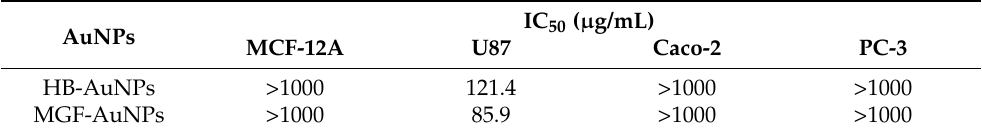
Figure 6. Investigation of the cytotoxic effects of HB-AuNPs and MGF-AuNPs in human cell lines. The in vitro effects of HB-AuNPs and MGF-AuNPs were tested in MCF-12A ( a ) U87 ( b ), Caco-2 ( c ) and PC-3 ( d ) cells. Data represented as the mean from three independent experiments. Error bars represent the standard error mean ( ± SEM). Data were considered to be statistically significant if p < 0.05, *** p < 0.001, ** p < 0.01, * p < 0.05. Table 3. IC 50 values of the AuNPs.